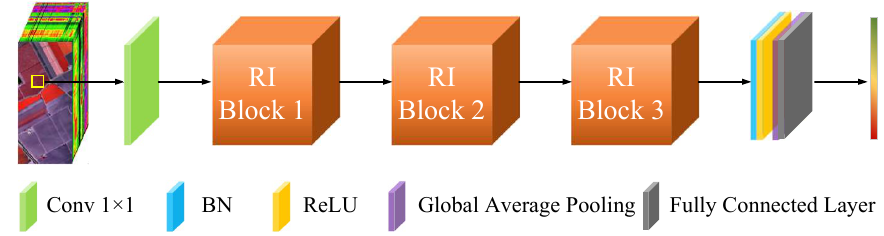
Figure 2. Overall architecture of the proposed